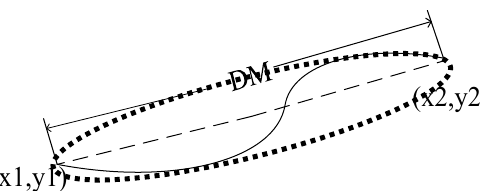
Figure 4. Maximum diameter of the circumscribed ellipse of the line.